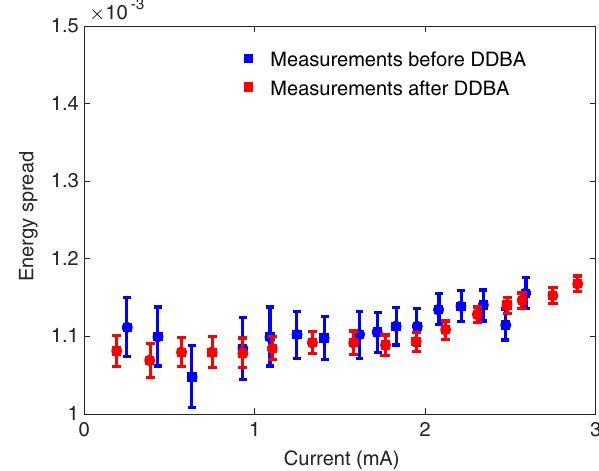
FIG. 11. Energy spread as a function of bunch current, before and after the installation of the DDBA cell.